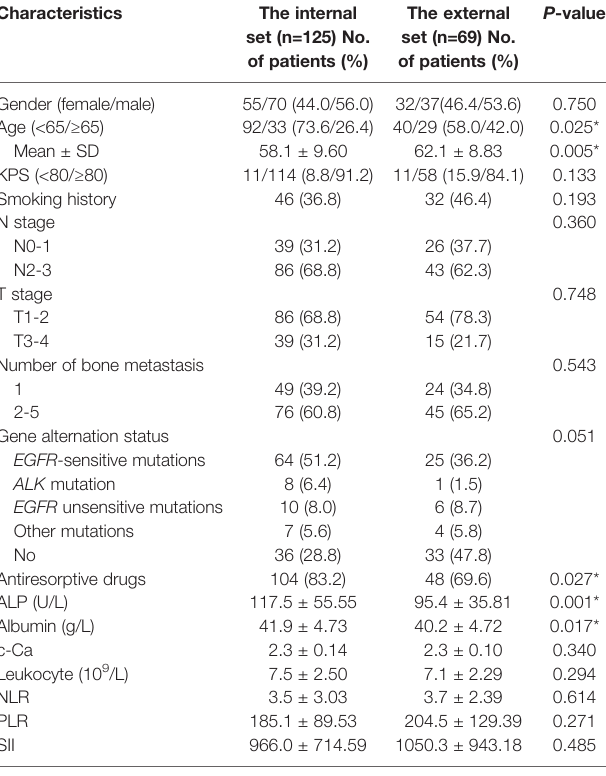
TABLE 1 | Clinical characteristics of patients. Characteristics The internal